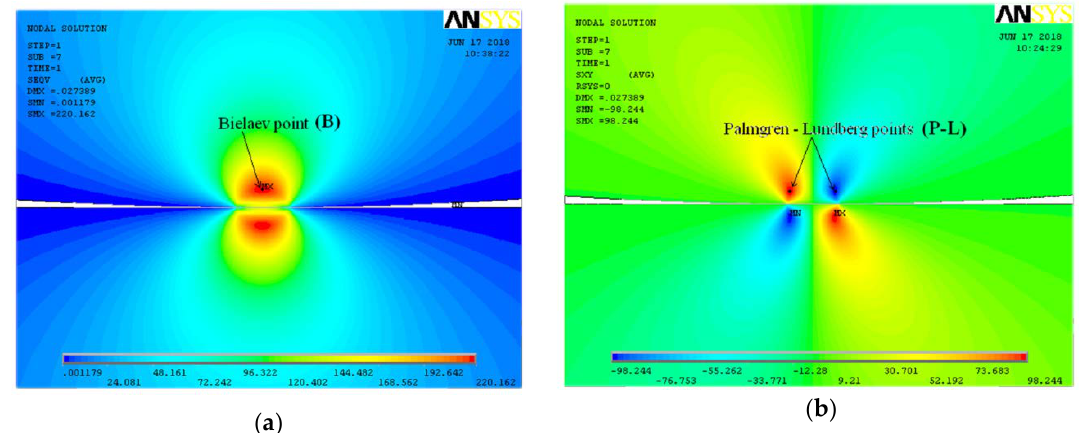
Figure 3. Distribution of subsurface stresses in rolling element (obtained by finite element method